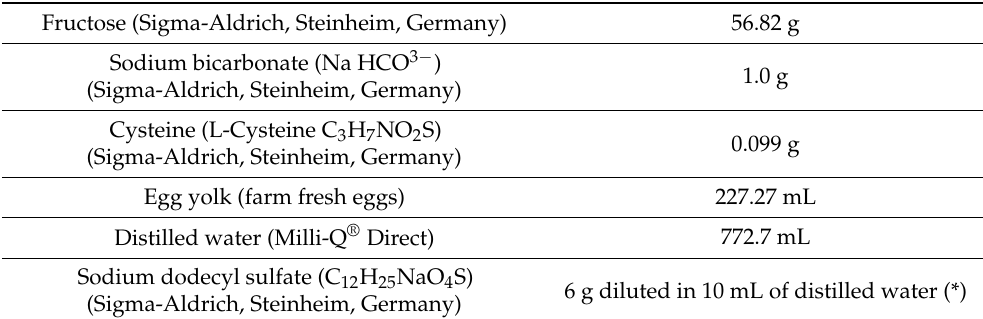
Table 3. Composition of IMIDA sperm-freezing extender (fraction A) for a total volume of 1 L (distilled H 2 O + egg